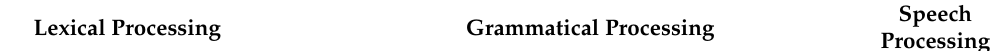
Table 2. Percentages of children with LD, SSD, LD+SSD who obtained clinical scores in Naming, Comprehension, Sentence Repetition, Comprehension, and Articulation subtests.